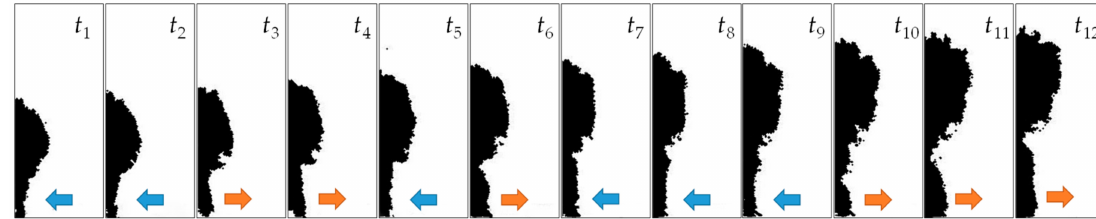
Figure 4. The wave structures of initial gas jets (100 m, expansion ratio of 1.5625).